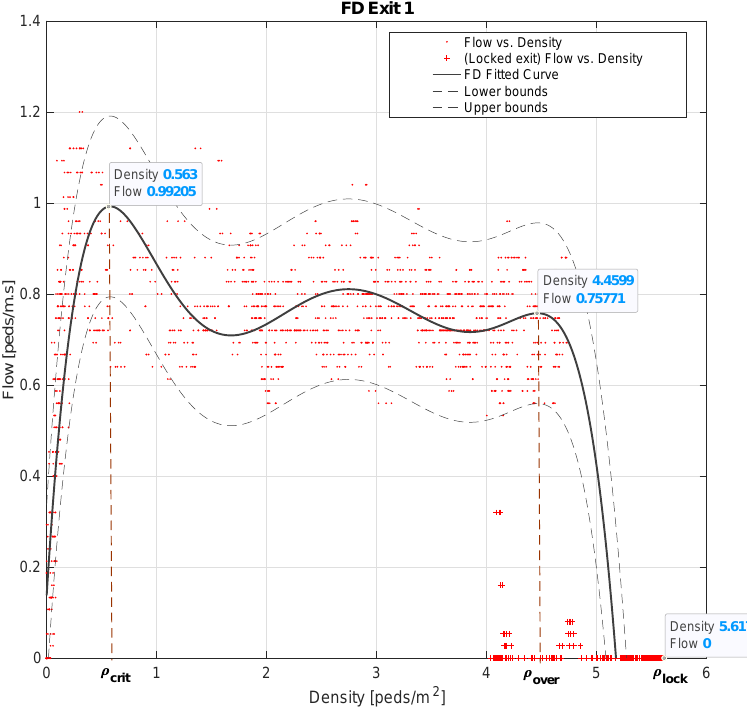
Figure 5. Fundamental diagram of exit